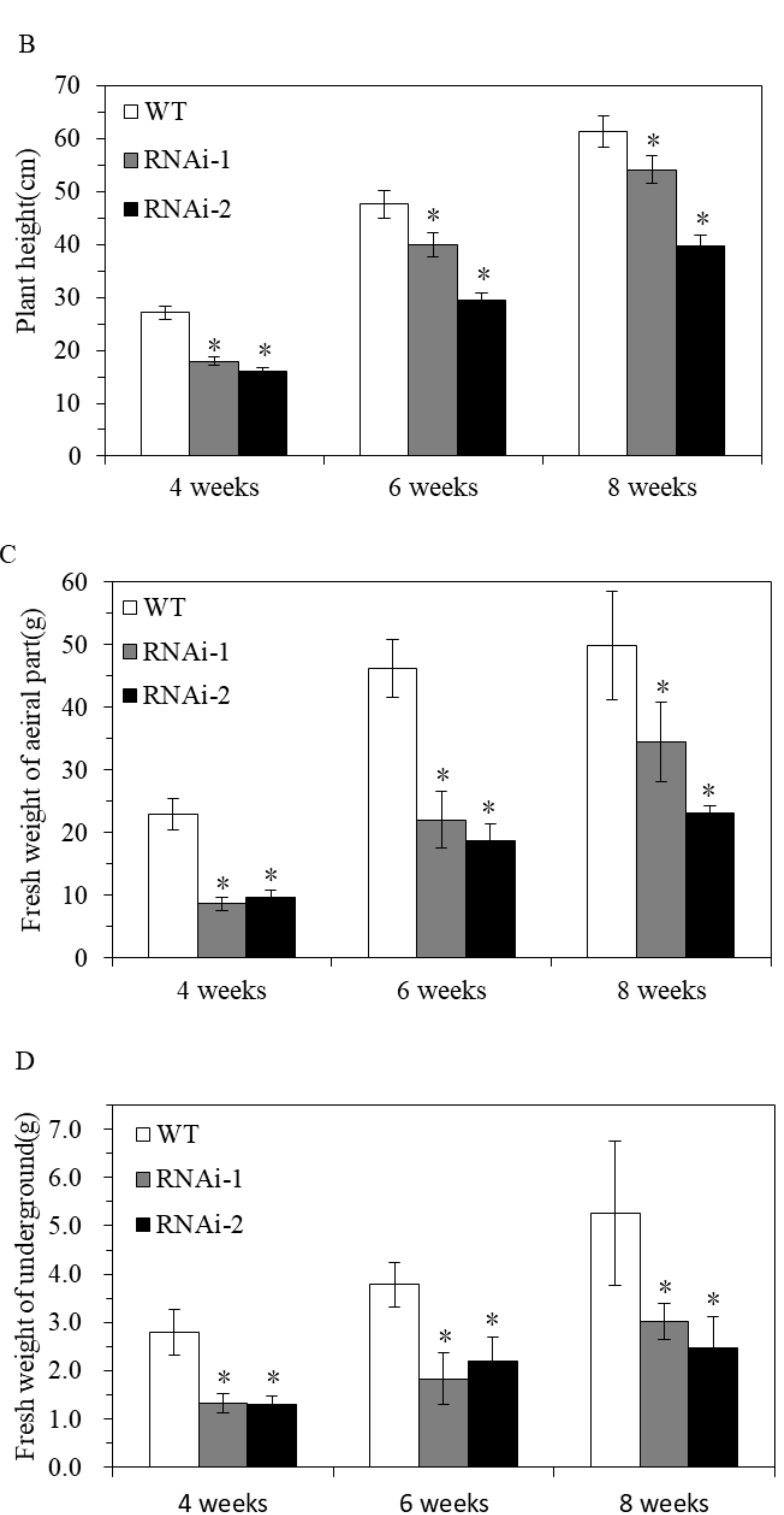
Figure 4. The phenotype of StSUT2-RNA interference plants ( A ) and its plants height ( B ) and fresh weight of the aerial ( C ) and underground parts ( D ). Plants were monitored within 4 weeks, 6 weeks, and 8 weeks of time duration. “*” means the difference is statistically significant between RNAi lines and WT.